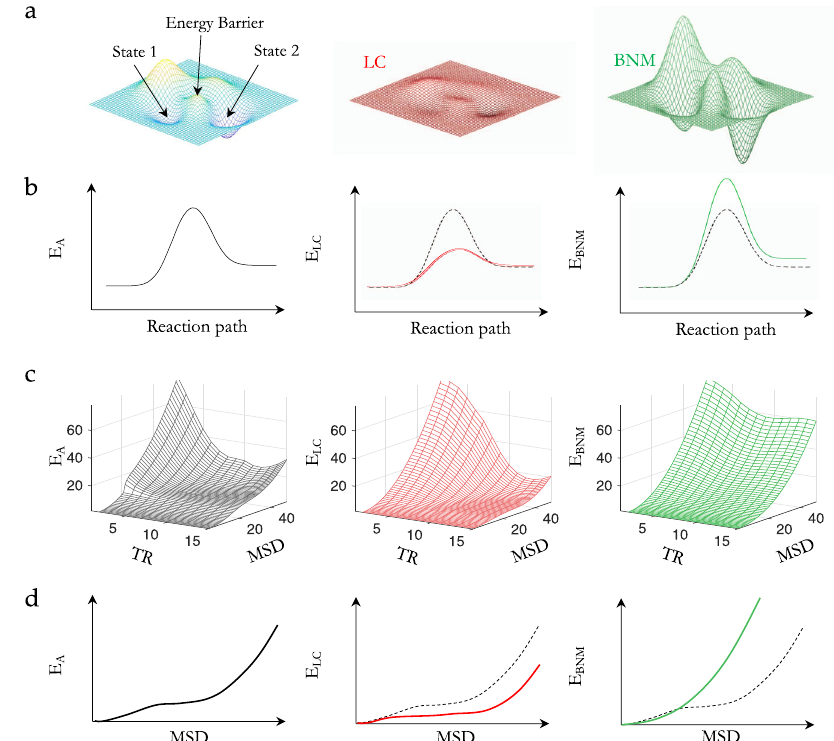
Fig. 2 LC and BNM mediated shifts in the brain-state energy landscape. a An example energy landscape, which de fi nes the energy required to move between different brain states: by increasing multiplicative gain, the LC should fl atten the energy landscape (red); by increasing response gain, the BNM should accentuate the energy wells (green). b The topography of the energy landscape can be conceptualized as similar to the activation energy ( E A ) that must be overcome in order to convert one chemical to another. c Empirical BOLD energy landscape as a function of mean-squared displacement (MSD) and TR of the baseline activity ( E A , black) and after phasic bursts in LC ( E LC , red) and BNM ( E BNM , green). d Empirical activation energy as a function of MSD averaged across lags t ¼ 10 : 15 ½ (cid:3) TR during base baseline activity ( E A , Left) and following phasic bursts in LC ( E LC , red) and BNM ( E BNM , green). Relative to the baseline energy landscape, phasic bursts in LC lead to a fl attening or reduction of the energy landscape, whereas peaks in BNM lead to an accentuation of the well by raising the energy